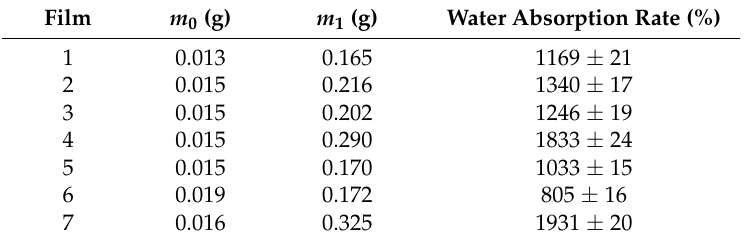
Table 1. Water absorption rates of the composite porous films.